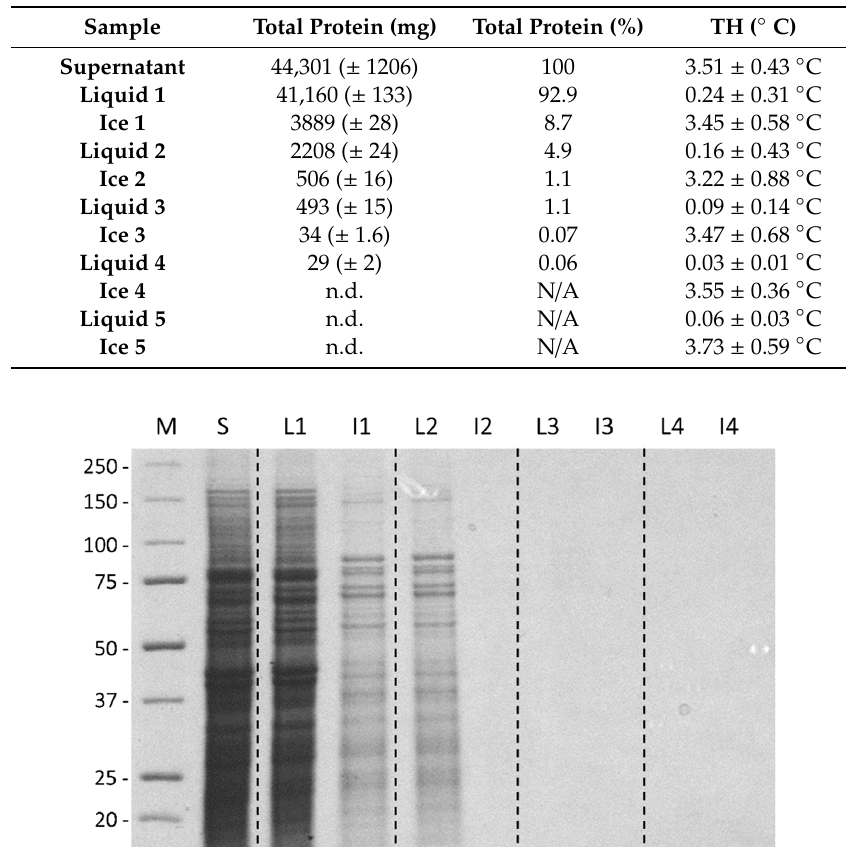
Table 1. Analysis of Tm AFP purification through five rounds of ice-a ffi nity purification. Total protein measured by the Bradford assay and TH readings were performed on liquid and ice fractions from Tm AFP purifications. All readings were done in triplicate, and all samples were assessed on an equal volume basis (400 mL), except for ice 5 with a final volume of ~275 mL. Total protein (mg) represents total quantity of protein in each 400 mL fraction, while total protein (%) represents the total protein in each fraction as a percentage of the supernatant. ± represents standard deviation (SD). Due to Tm AFP’s inability to bind Coomassie blue, this protein is present but not detected (n.d.) in Ice 4 and Ice 5.